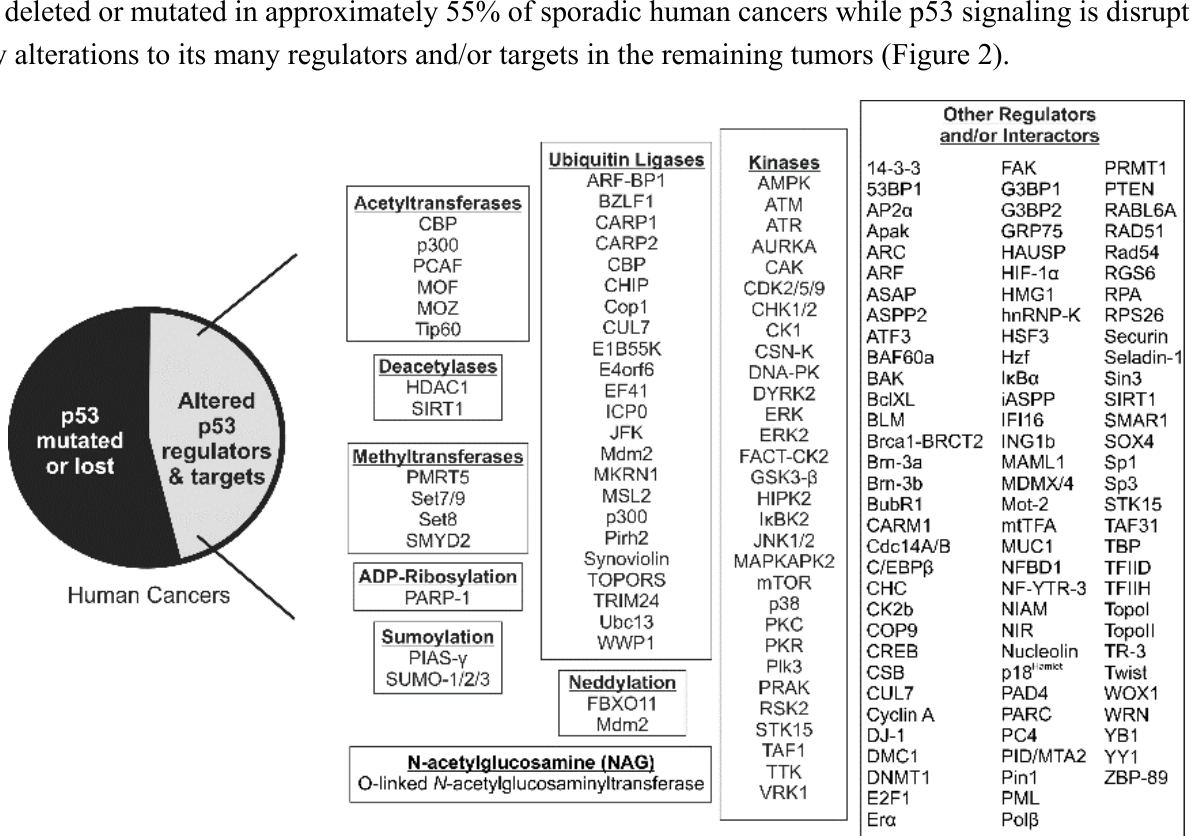
Figure 2. The p53 signaling pathway is altered in the majority of human cancers. The TP53 gene is deleted or mutated in approximately 55% of human cancers while its signaling is disrupted by alterations to its many regulators (listed to the right) and/or targets (not listed) in the remaining